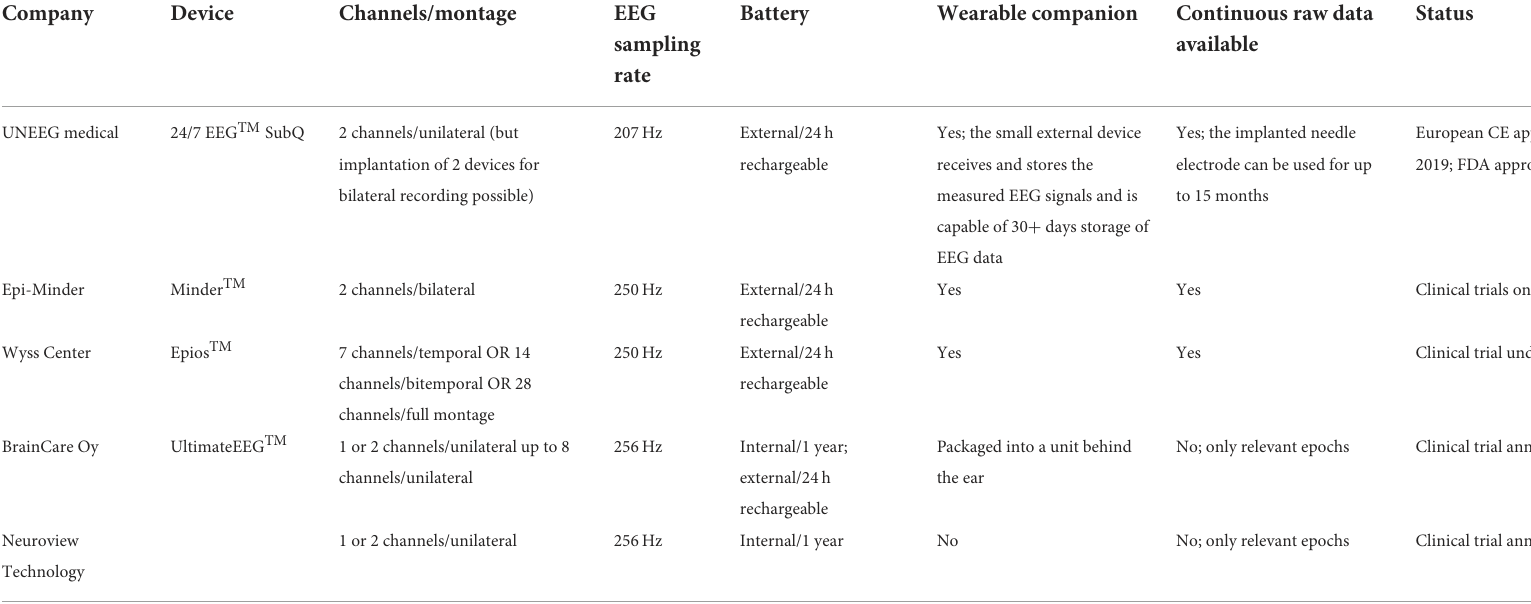
TABLE 1 Overview and characteristics of known subscalp EEG devices certified or currently in development for humans.